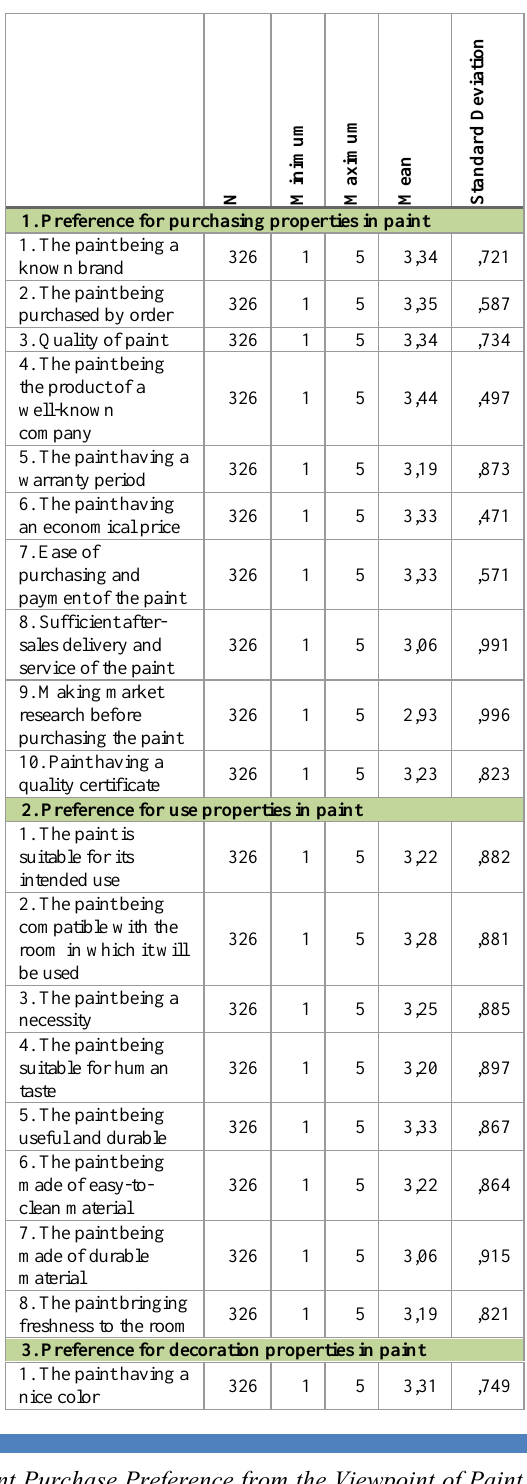
Table 12: Findings on Income Level most important factors in the emergence of need for paint. However, the most important factor affecting the Frequency % purchasing preference of consumers had been determined as previous knowledge and experience. Findings on Consumers' Preferences for Paint Table 14: Findings on Consumers' Preferences for